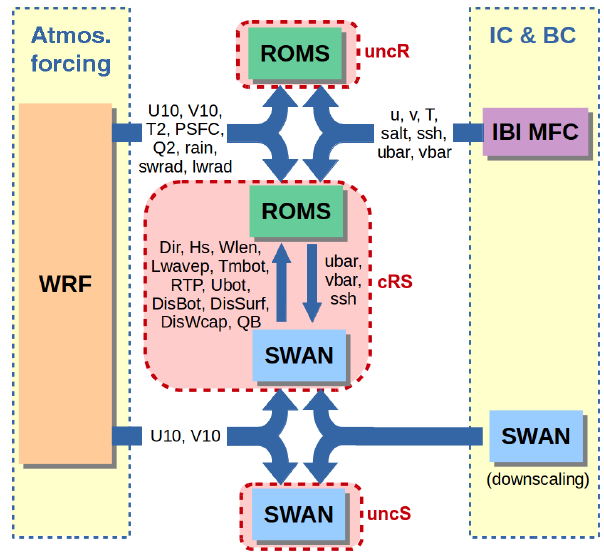
Figure 2. Configuration of setup run. In red is the name given to each